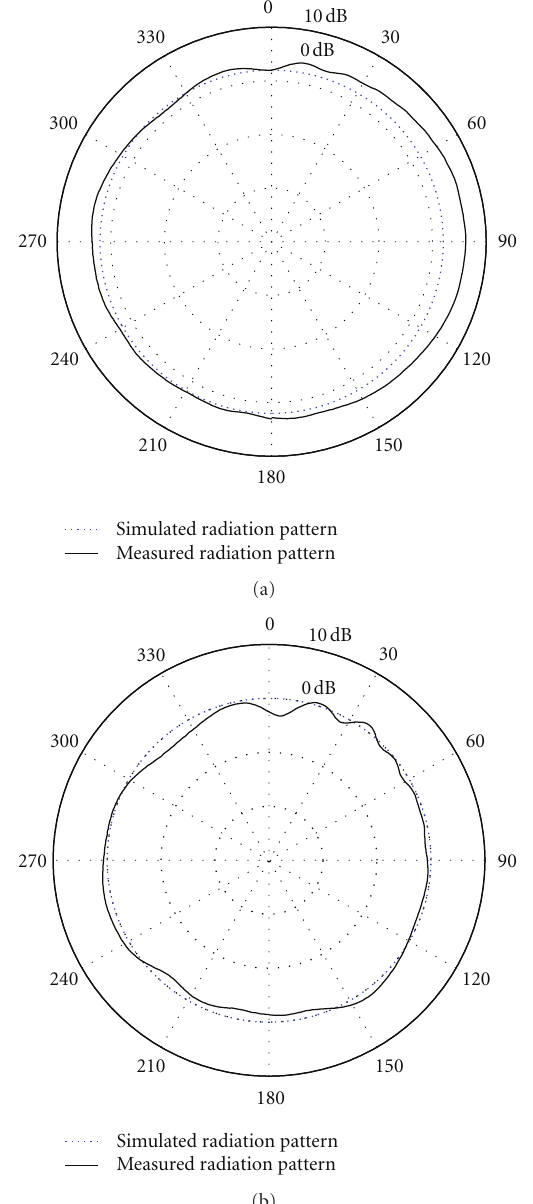
Figure 9: Simulated and measured XZ-plane patterns of the proposed antenna, 10dB per division. (a) 3.15GHz, (b) 7.2 GHz.